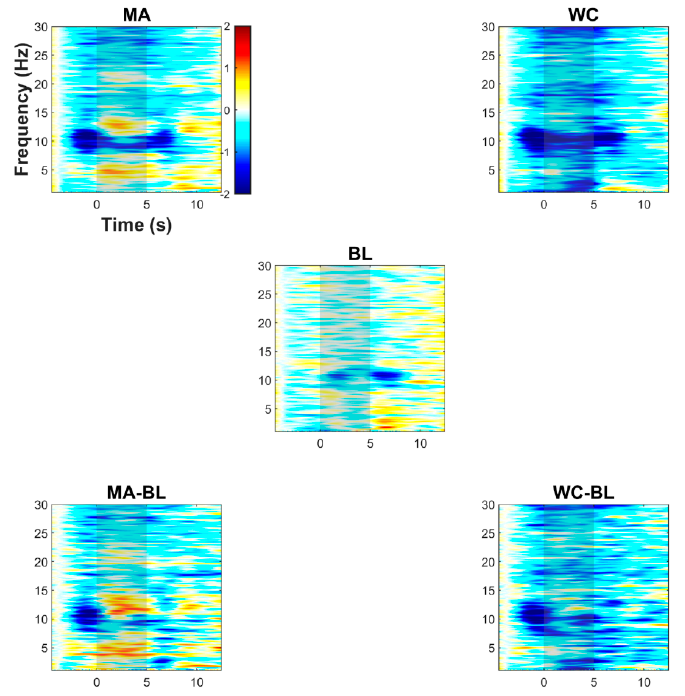
Figure 3. Event-related (de)synchronization (ERD/S) induced by MA, WC, BL, MA-BL (difference between MA and BL), and WC-BL (difference between WC and BL) in the frontal area. The results are calculated by averaging the spectral power changes measured at the 10 frontal electrodes (AFp1, AFp2, AFF1h, AFF2h, AFF5h, AFF6h, F3, F4, F7, and F8). A common colorbar for all five subplots indicates the range of the map in dB. The gray patches indicate the task period of 0–5 s.